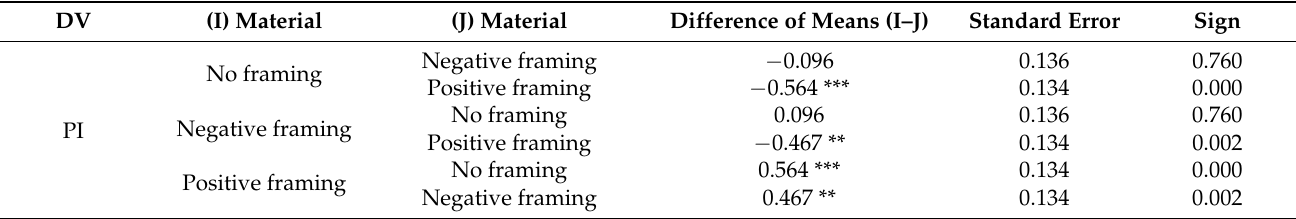
Table 5. Results of Tukey HSD test after